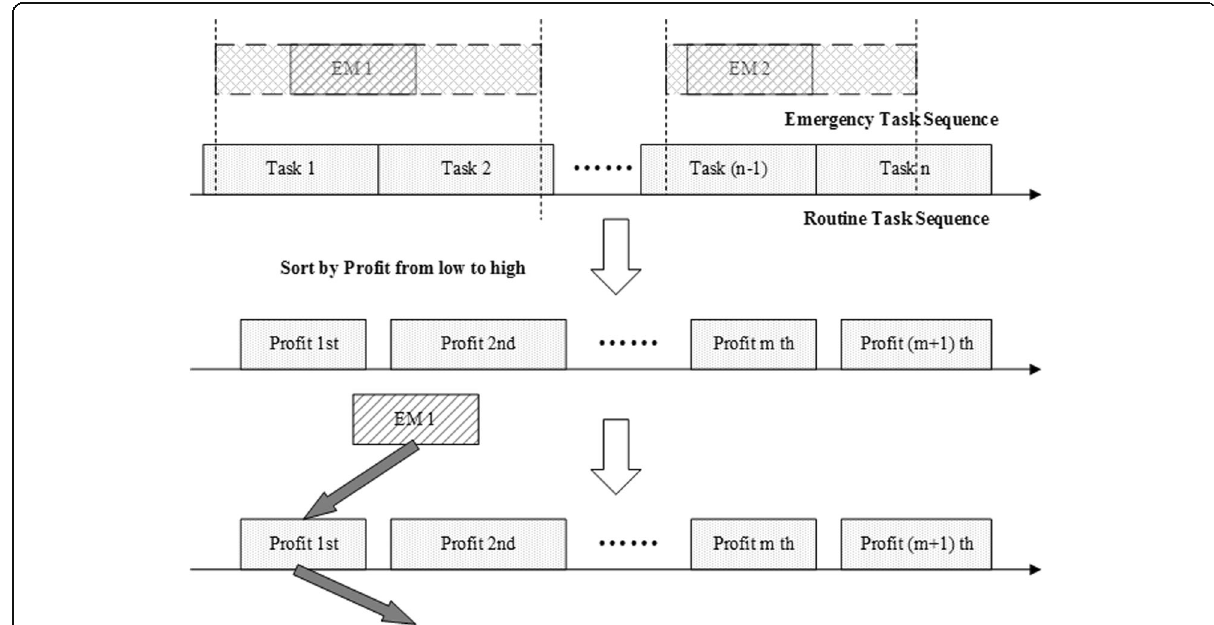
Figure 4 described the process of replanning the task plan after choosing the location of emergency task in Algorithm III. The data from l value of the five task execution paths. In the process